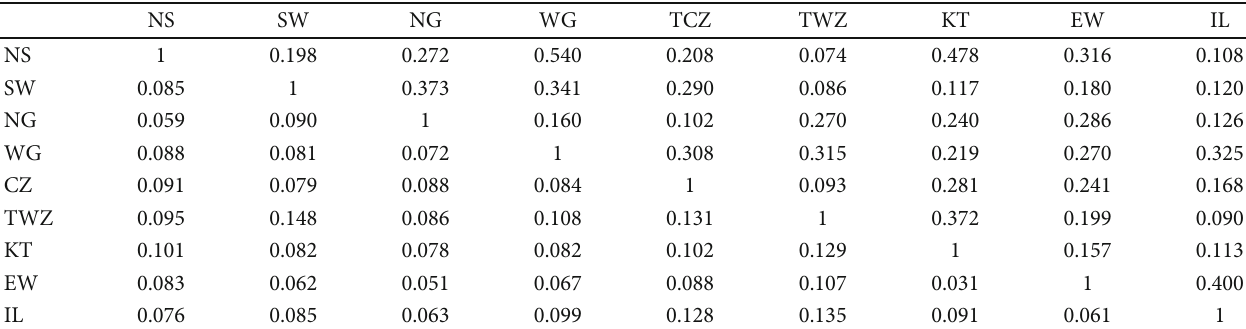
Table 4: Pairwise Nei ’ s unbiased genetic distance (upper diagonal) and pairwise FST (lower diagonal).